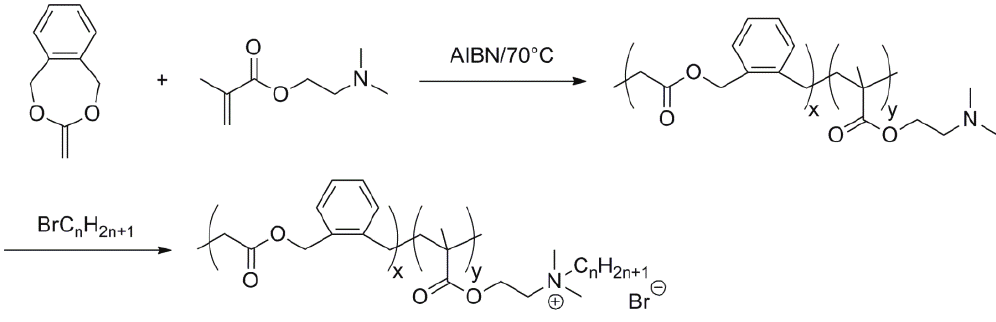
Figure 11. CROP involving active chain ends; S